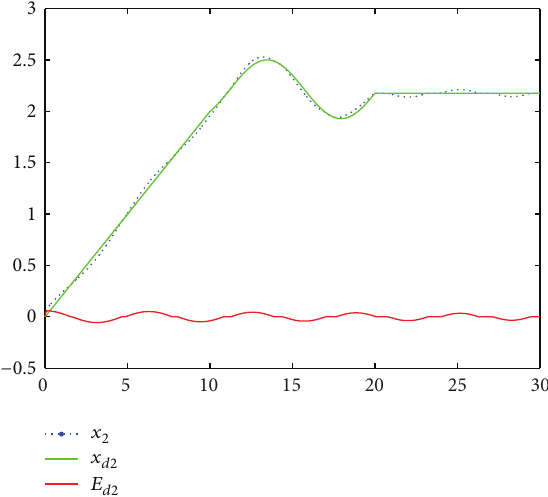
Figure 7: Trajectory tracking result for system state 𝑥 1 . Figure 8: Trajectory tracking result for system state